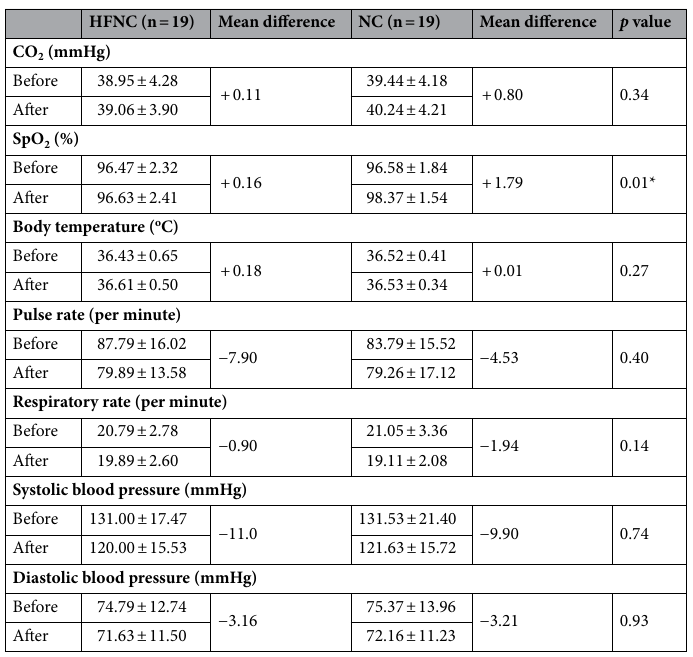
Table 4. The effect of HFNC and NC intervention on physiological parameters. Analysis of covariance (ANCOVA) test, p < 0.05. HFNC high flow nasal cannula, NC nasal cannula, CO 2 carbon dioxide, SpO 2 peripheral capillary oxygen saturation. *Significance between high-flow nasal cannula and nasal cannula.